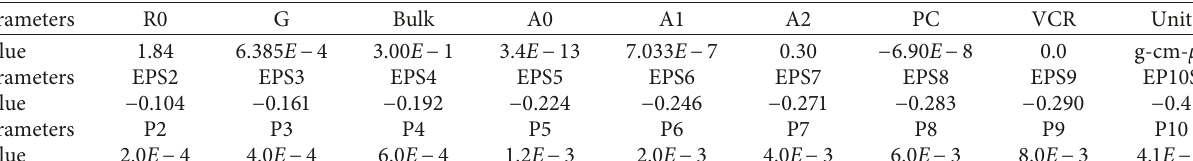
Table 7: Material parameters of soil [16–18].